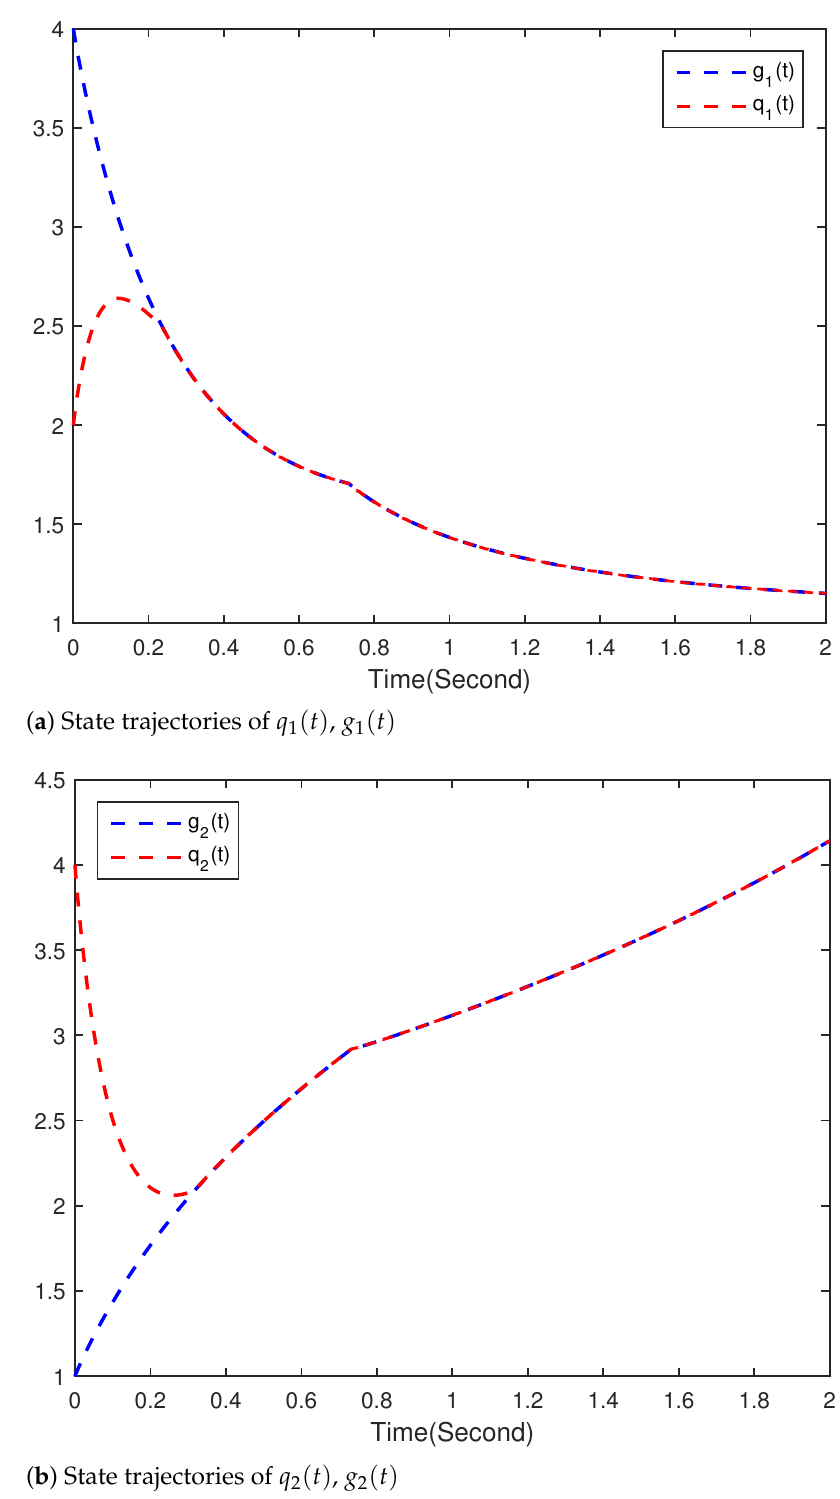
Figure 3. Time responses of q ( t ) and g ( t )